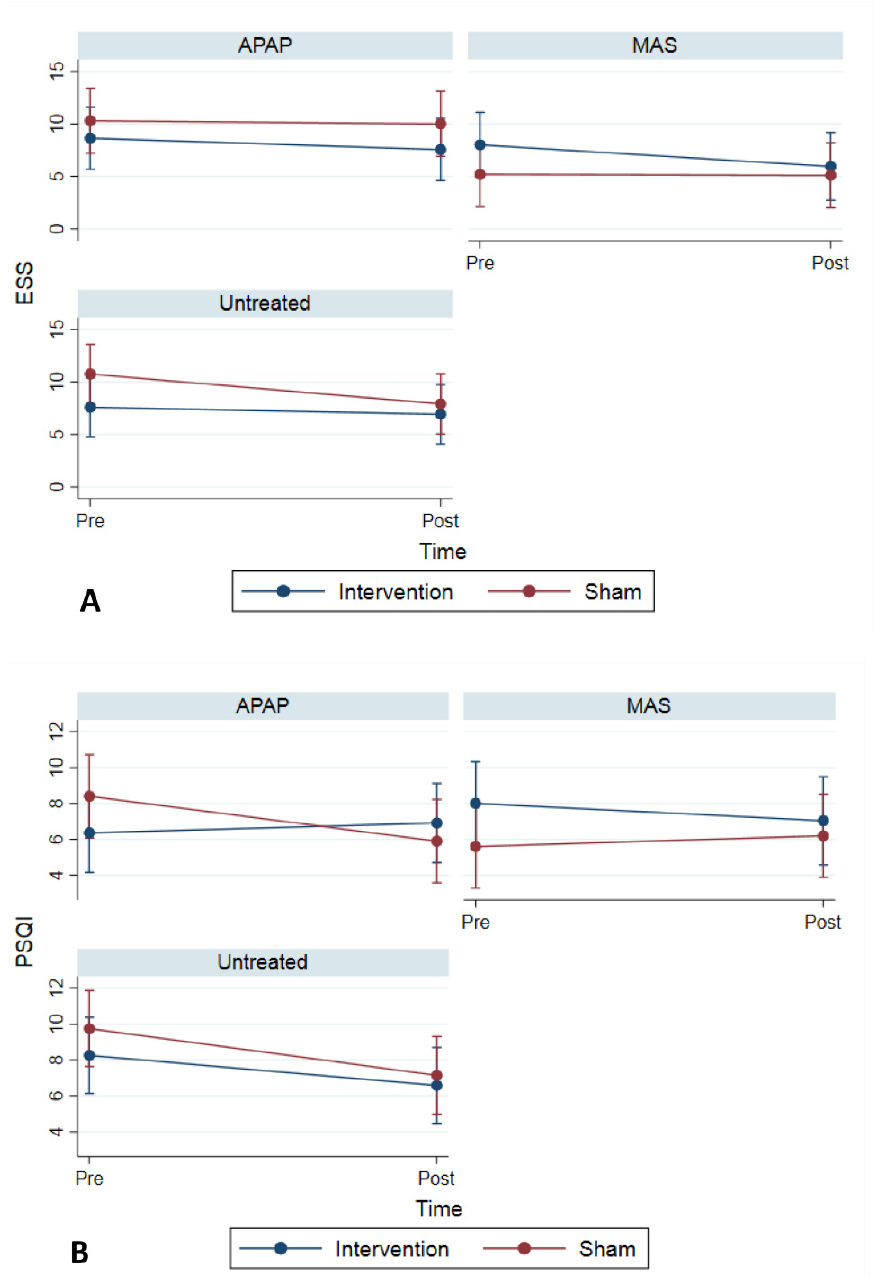
Figure 4. ( A ) Change in Epworth Sleepiness Scale (ESS) across treatment groups. ( B ) Change in Pittsburgh Sleep Quality Index (PSQI) across treatment groups.